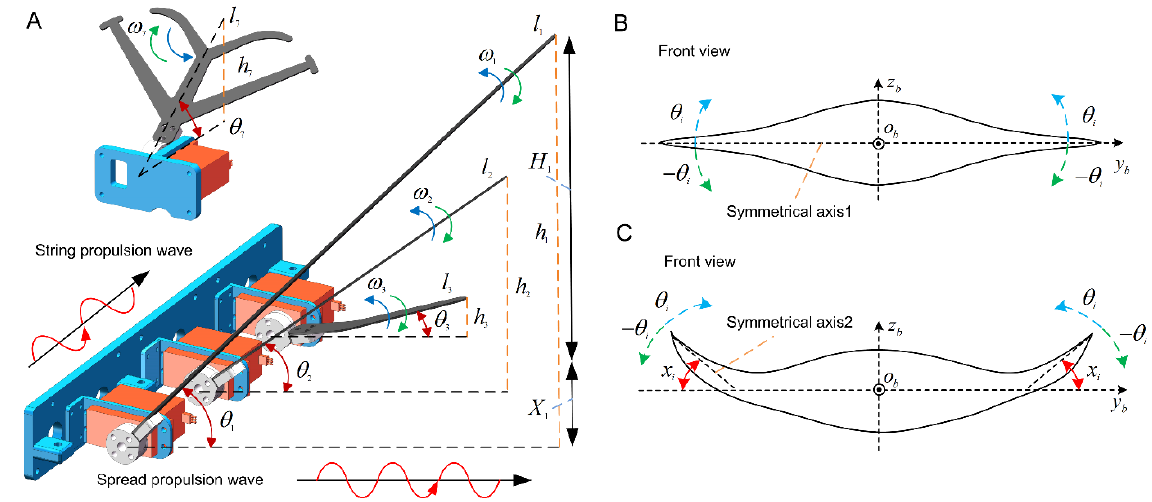
Figure 3. The principle of basic motion. ( A ) The movements of pectoral and caudal fins. ( B , C ) The instructions of bias angle, where i = 1,2, . . .